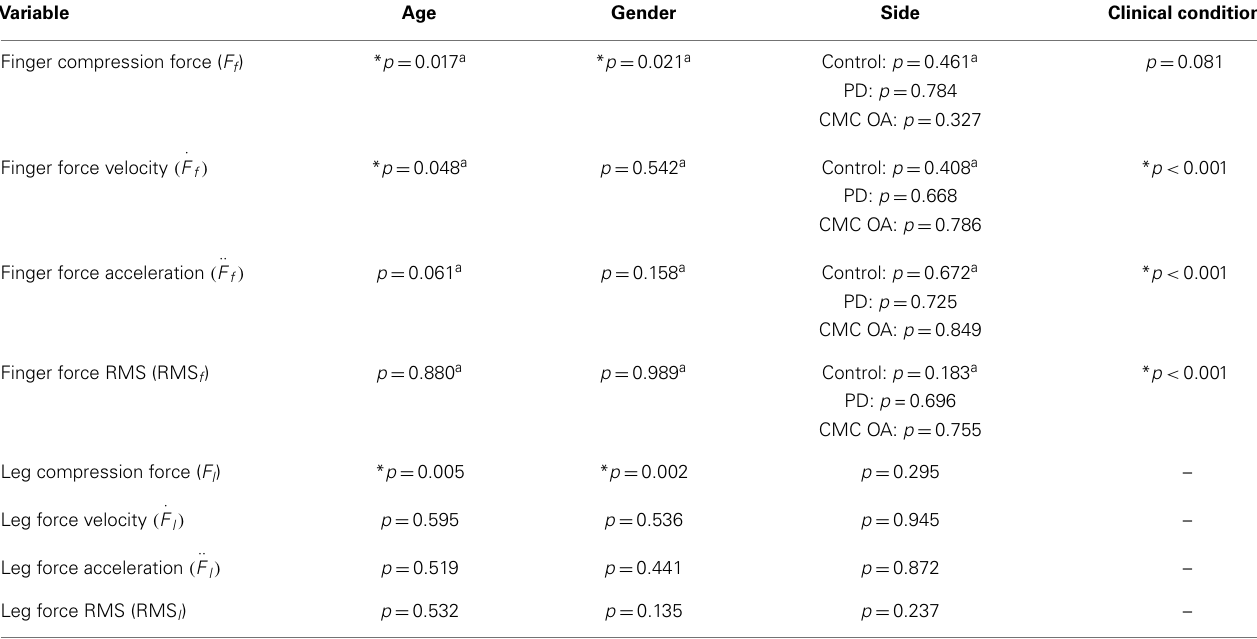
Table 2 | Summary of multifactorANOVA results .